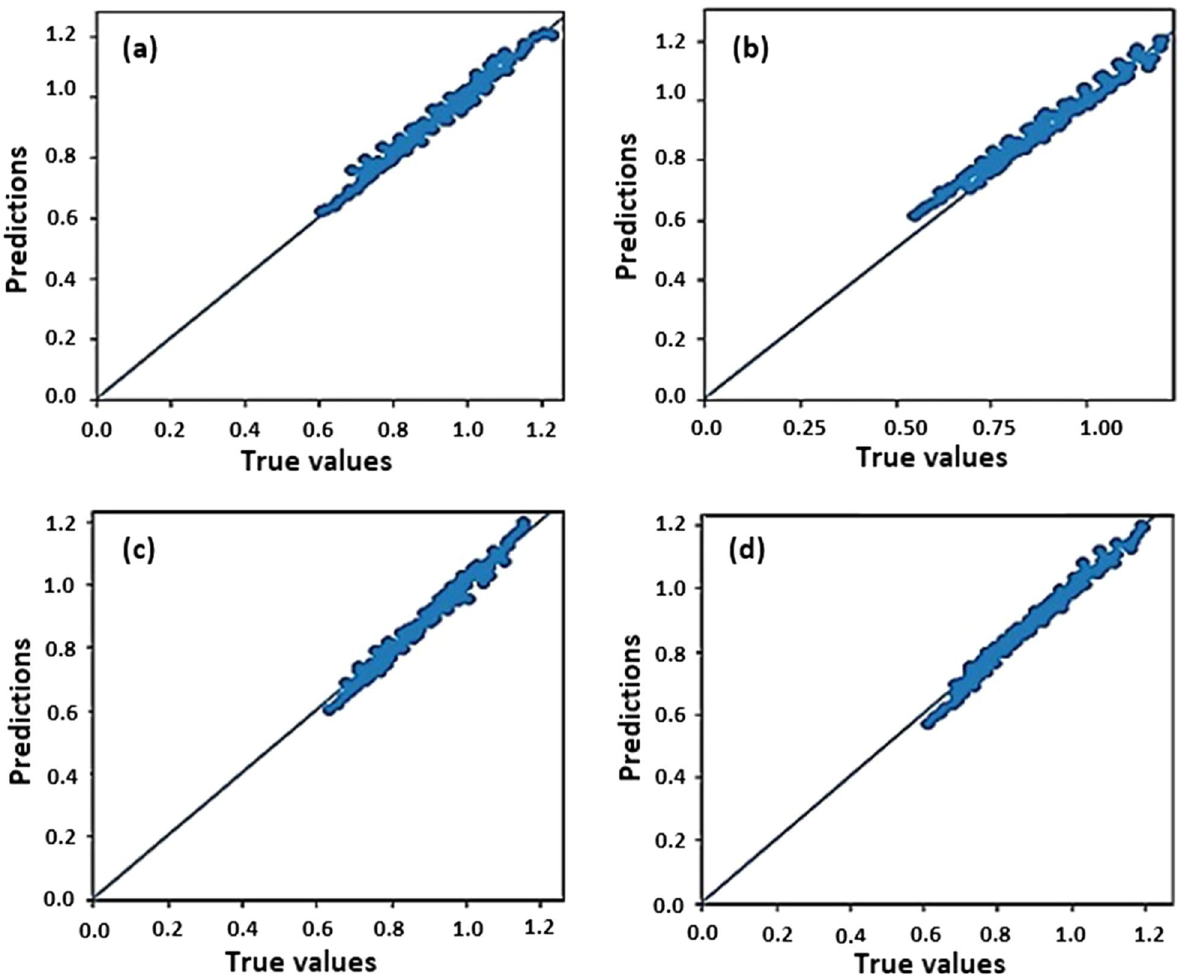
Figure 4. Testing the trained MLP neural network using the four sample datasets, each 100 data of K value with variables including ( a ) E = 18 MeV, ml1 = ml2 = 4 cm ( b ) E = 20 MeV, ml1 = 4 cm and ml2 = 3 cm, ( c ) E = 20 MeV